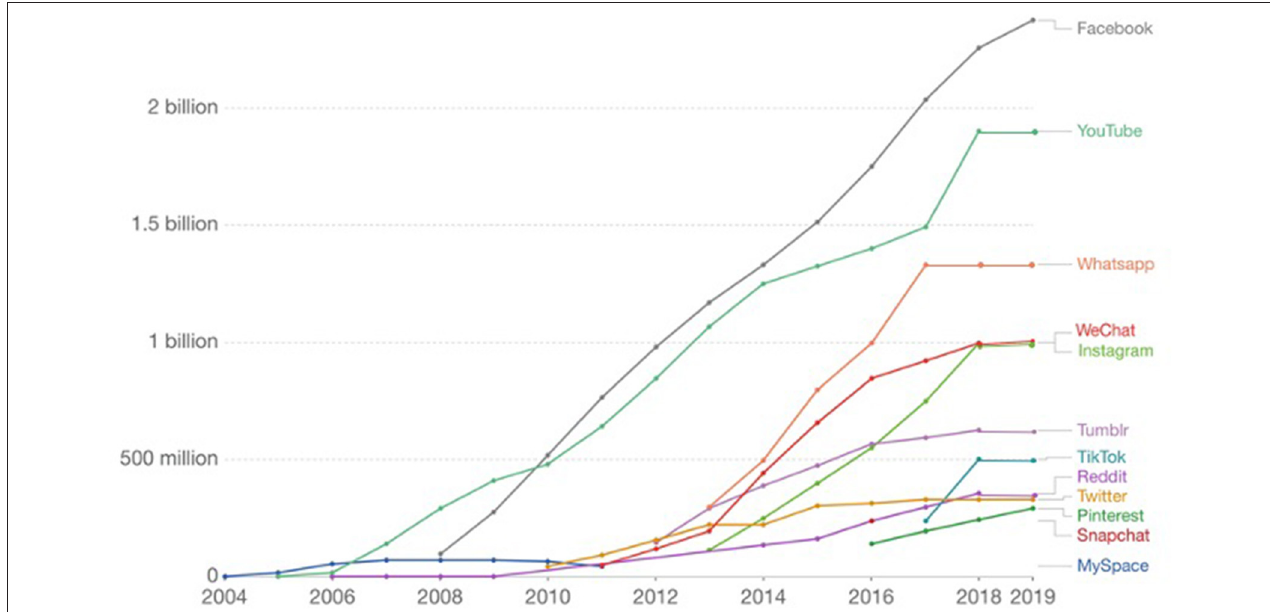
FIGURE 1 | Number of people using social media from 2004 until the end of 2019; estimates correspond to monthly active users, defined as those who logged in during the past 30 days. Source: Esteban Ortiz-Ospina (2019)–-“The Rise of Social Media,” published online at ourworldindata.org and retrieved from